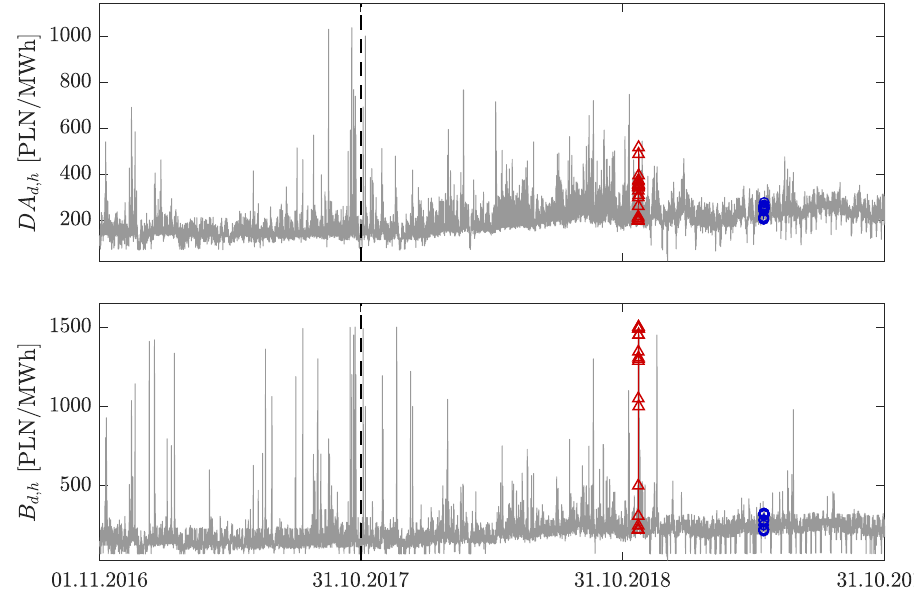
Figure 1. Day-ahead (top) and balancing (bottom) hourly electricity system prices in Poland from the period 1 January 2017–30 September 2019. The dashed line marks the beginning (1 November 2017) of the two-year evaluation period. The red triangles (24 h of 22 November 2018) and blue circles (24 h of 16 May 2019) correspond to the two largest draw-downs in profitability, see Section 5.2 and Figure 4.